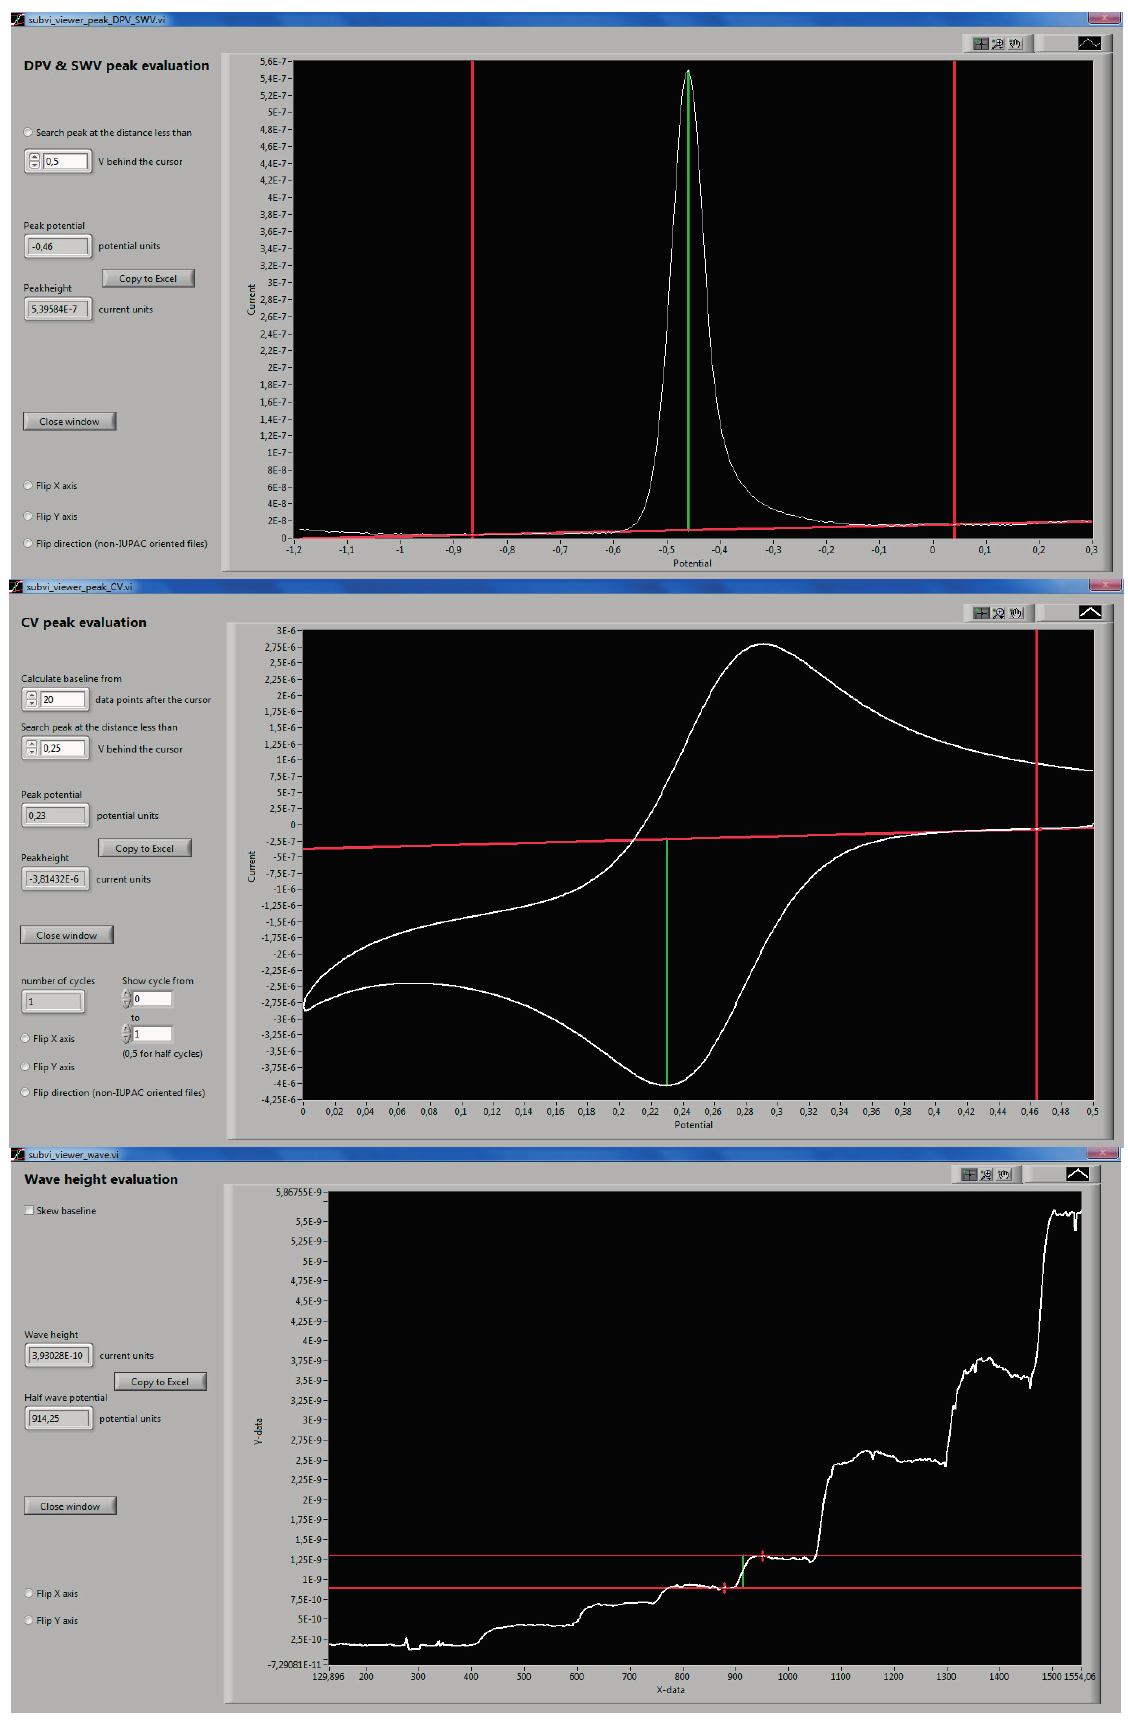
Figure 4. Peaks and waves evaluation subroutines’ front